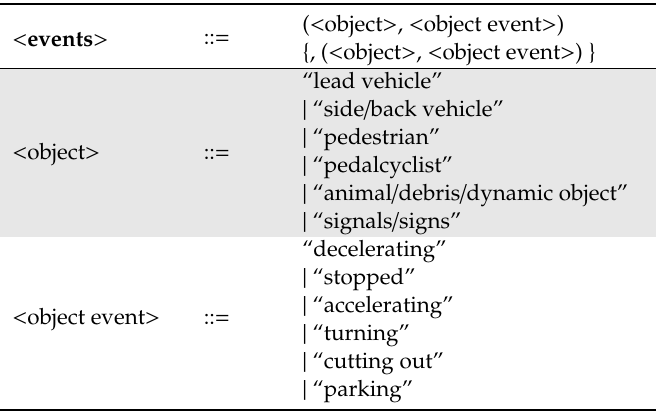
Table A12. The 1st and 2nd stages of < events >